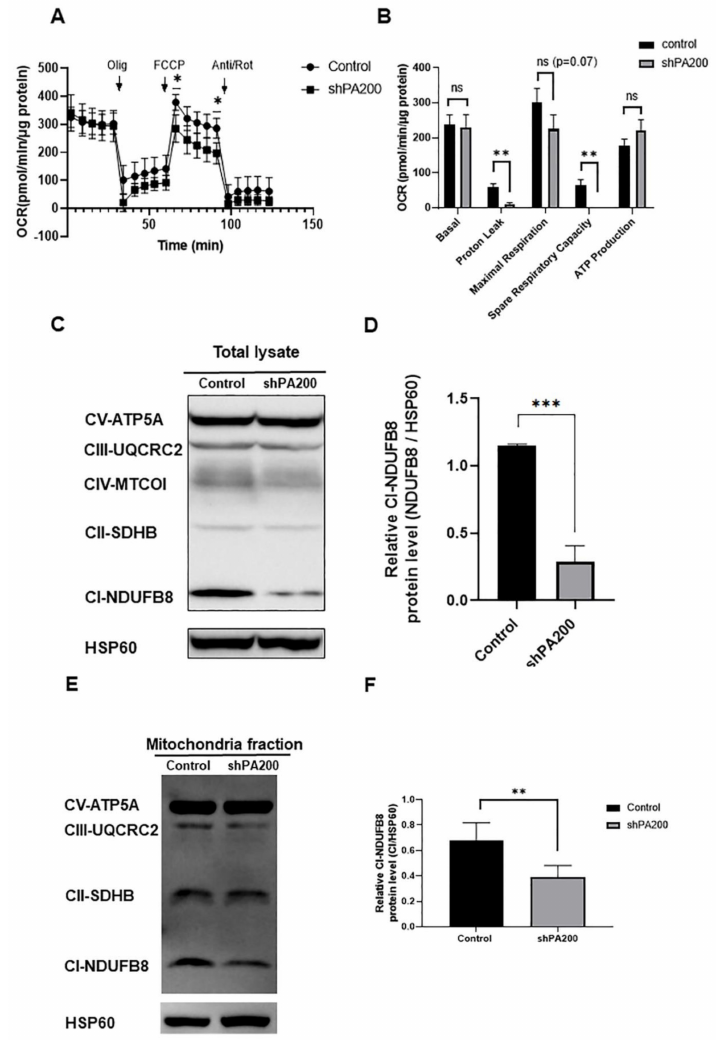
Figure 3. The genetic ablation of PA200 results in deficient mitochondrial function. ( A ) Oxygen consumption rate (OCR) was measured using the Seahorse XF 96 to analyze mitochondrial function. Control and shPA200 cells were seeded at a density of 35,000 cell/well in Seahorse XF 96 plates. The following day, the basal OCR was determined for 30 min after sequentially injecting mitochondrial drugs, including 1.5 µ M oligomycin (Olig), 1 µ M FCCP, and 1 µ M of rotenone/antimycin-A cocktail (Anti/Rot). Data were analyzed using Wave Desktop software and presented as mean values ± SD ( n = 3). Statistical analysis was performed using unpaired t -tests. (* indicates p < 0.05) ( B ) Calculated basal respiration, proton leak-linked respiration, maximal mitochondrial respiratory capacity, spare respiratory capacity, and ATP-coupled respiration. Data were normalized to total protein (pmol/min/ µ g protein). Data were analyzed using Wave Desktop software and presented as mean values ± SD ( n = 3). Statistical analysis was performed using unpaired t -tests. (** indicates p < 0.01 and ns indicates not significant). ( C ) Total cell lysates from control and shPA200 cells were analyzed by western blot. OXPHOS antibody cocktail was used to detect four subunits of the electron transport chain (ETC) complexes, CI-NDUFB8, CII-SDHB, CIII-UQCRC2, and CIV-MTCOI, and one subunit for the ATP synthase, CV-ATP5A. Images were taken using a ChemiDoc Imager, and the density of the protein was normalized to the mitochondrial Hsp 60. ( D ) Statistical histogram of CI-NDUFB8 subunit from total lysates of PA200-deficient and control cells. Data were analyzed using Image Lab V 6.1 software and presented as mean values ± SD ( n = 4). Groups were compared using unpaired t -tests. (*** indicates p < 0.001). ( E ) Mitochondria fractionation from control and shPA200 cells were performed and analyzed by western blot. The OXPHOS antibody cocktail was used to detect four subunits of the electron transport chain (ETC) complexes, CI-NDUFB8, CII-SDHB, CIII-UQCRC2, CIV-MTCOI, and one subunit for the ATP synthase, CV-ATP5A. Images were taken using a ChemiDoc Imager and the density of the protein was normalized to the mitochondrial Hsp 60. ( F ) Statistical analysis of the CI-NDUFB8 subunit from mitochondrial sufractions of shPA200 and control cells. Data were analyzed using Image Lab V 6.1 software and presented as mean values ± SD ( n = 4). Groups were compared using unpaired t -tests. (** indicates p <